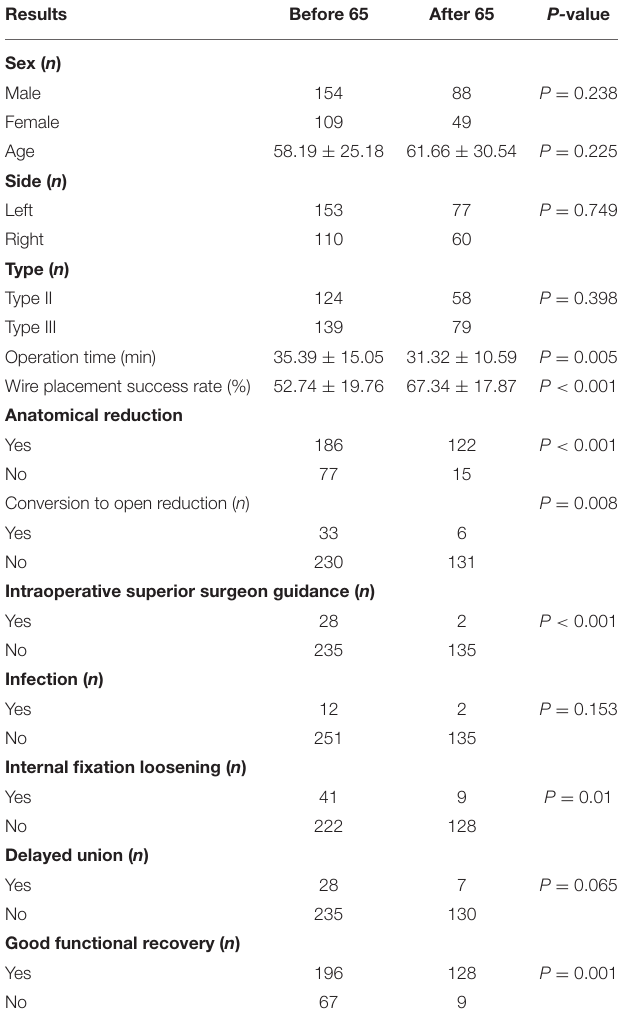
TABLE 4 | Comparison of characteristics of patient, before, and after accumulation of surgical